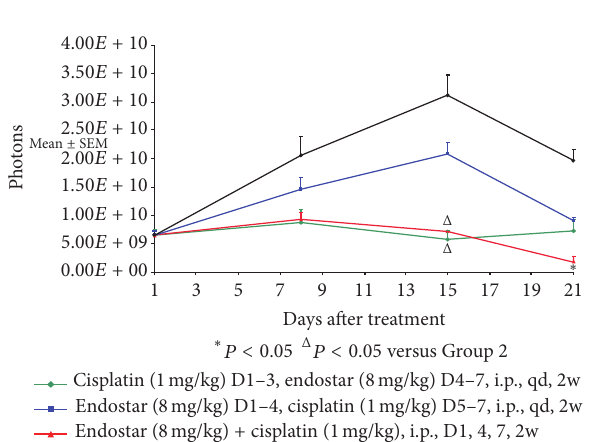
Figure 2: Photons analysis of the four experimental groups.